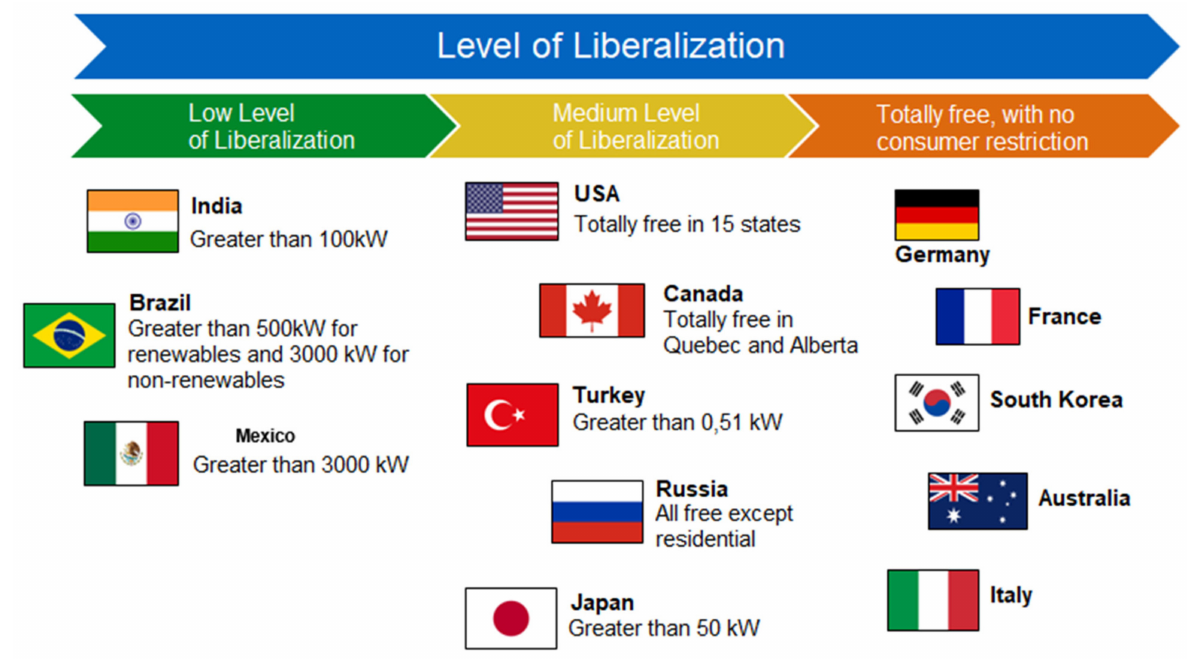
Figure 7. Degree of liberalization of the electric energy market (adapted from